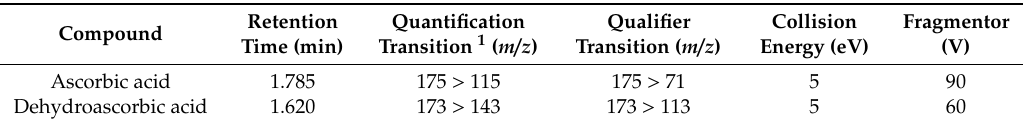
Figure 1. Representative overlap and individual spectra of dehydroascorbic ( a and b , repectively), and ascorbic ( a and c , respectively) acids obtained by UHPLC-ESI-QqQ-MS / MS working in the multiple reaction monitoring mode. Table 1. Optimal multiple reaction monitoring (MRM) transitions and parameters for quantification of ascorbic and dehydroascorbic acids (AA and DHAA, respectively) by UHPLC-QqQ-MS/MS working in negative ionization mode.